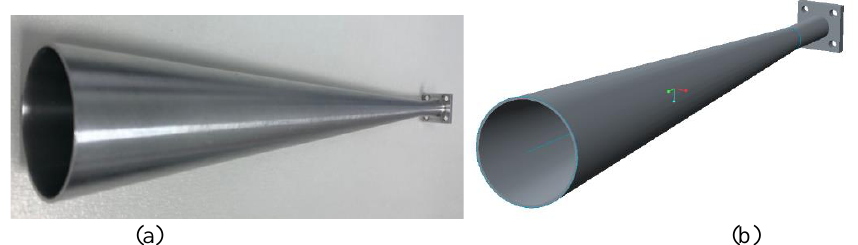
Fig. 2. Prototype (a) and 3D model (b) of a conical